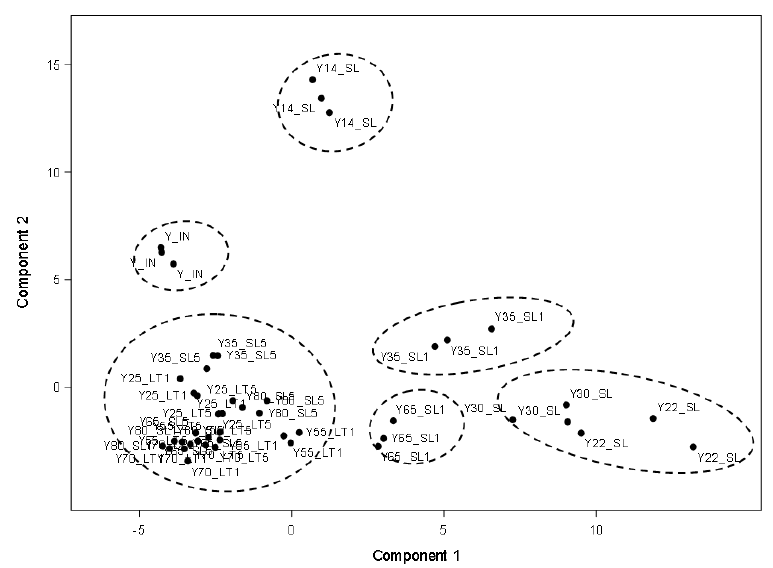
Figure 7. Score plot of PC1 and PC2 for cultivar ‘Yali’ ripening in different storage regimes. (Y-‘Yali’; IN-storage start; 14, 22, 25, 30, 35, 55, 65, 70, 80-storage days; LT1, LT5-low storage at 1 or 5 °C; SL-shelf life at 20 °C; SL1, SL5-shelf life at 20 °C after storage at 1 or 5 °C).